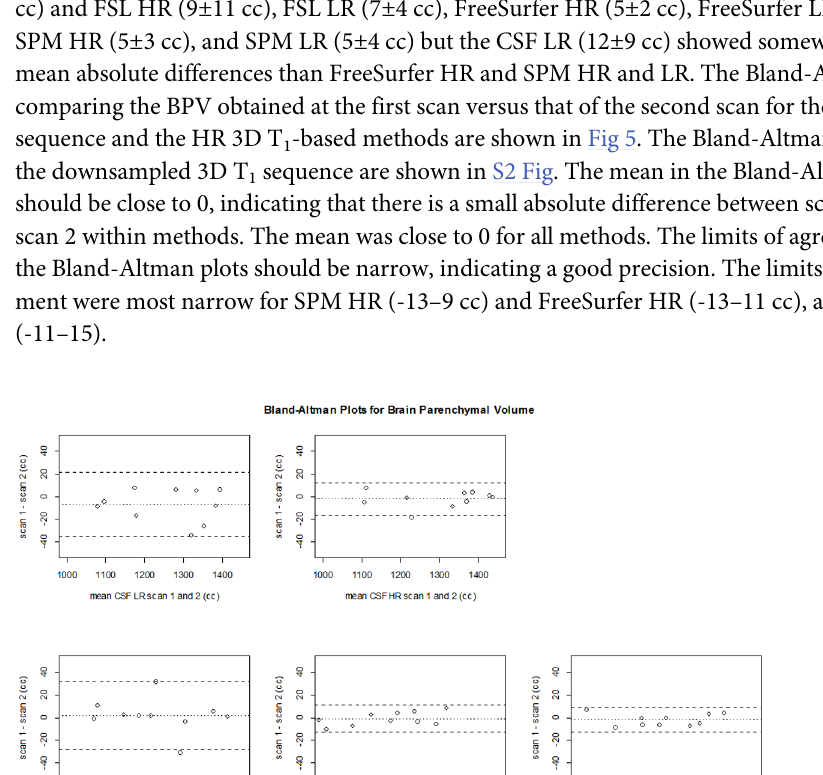
Fig 5. Bland Altman plots for precision of BPV per method. CSF LR, CSF HR (top row), FSL, FreeSurfer and SPM (bottom row). The dashed lines represent the limits of agreement (mean difference ±1.96 (cid:3) SD of the differences). CSF LR = CSF low resolution MRI scan; CSF HR = CSF high resolution MRI scan; FS =